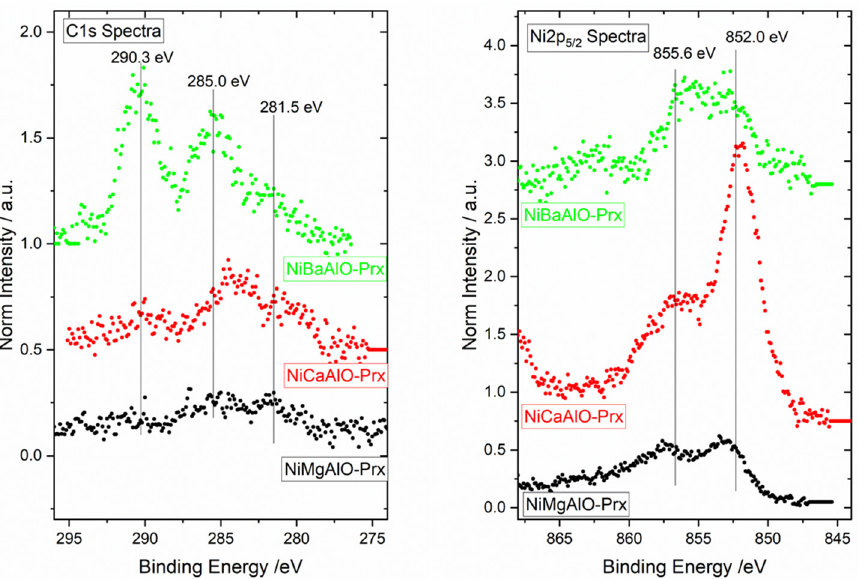
Figure 9. XPS spectra corresponding to the Ni2p 3/2 and C1s regions of the NiBaAlO-PRx, NiMgAlO- PRx, and NiCaAlO-PRx post-reaction samples.